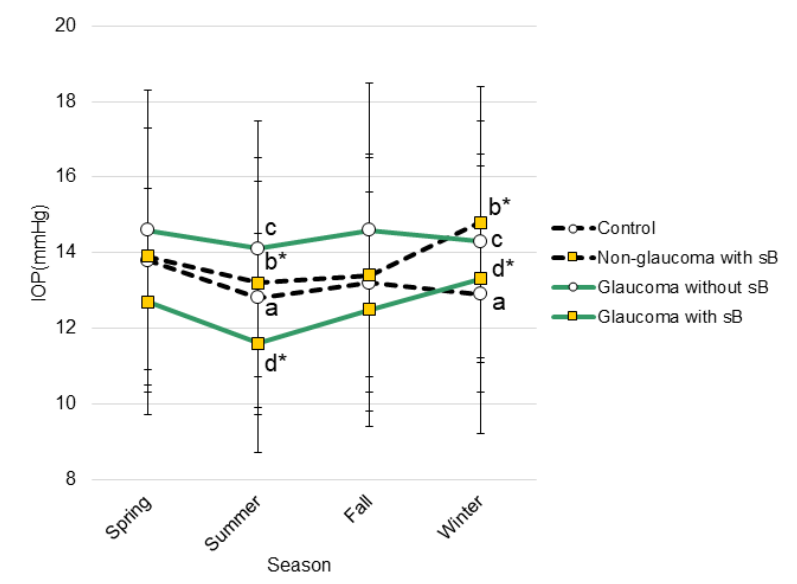
Figure 1. Seasonal variation in intraocular pressure (IOP).